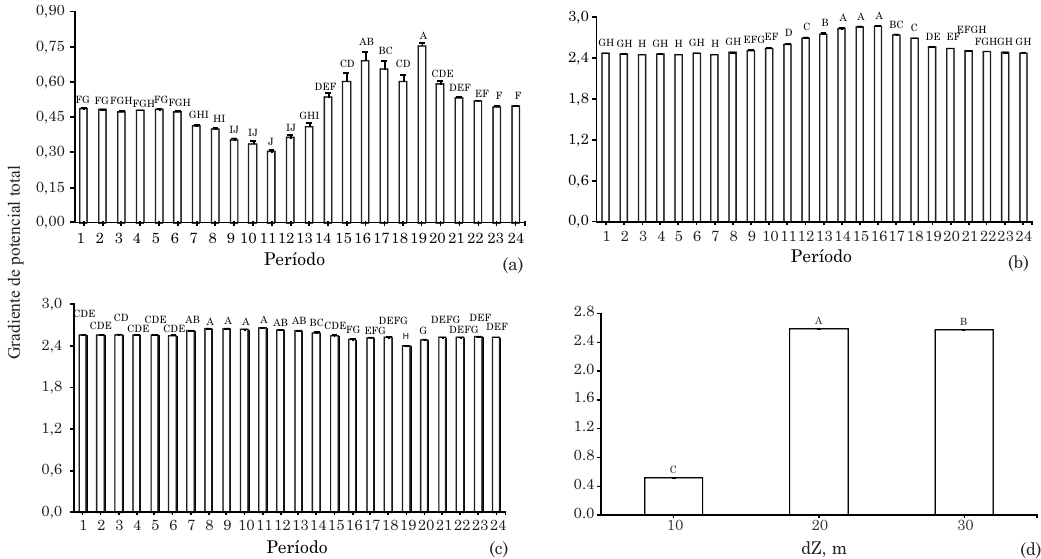
Figura 3. Gradiente de potencial total da água no solo nas profundidades de 0,25 m (a, b, c), calculado com ∆∆∆∆∆ z de 0,10 m (tensiômetros nas profundidades de 0,20 e 0,30 m); 0,20 m (tensiômetros nas profundidades de 0,15 e 0,35 m); e 0,30 m (tensiômetros nas profundidades de 0,10 e 0,40 m), em função dos 24 períodos do dia e (d) comparação de médias pelo teste de Tukey a 5